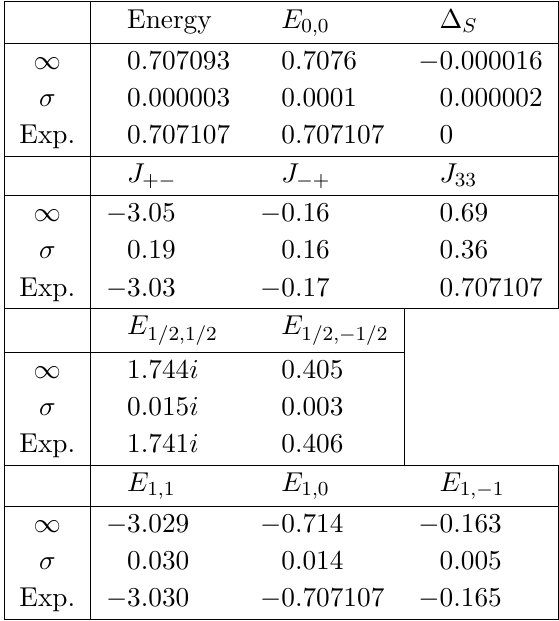
Table 13 . Extrapolations of gauge invariants of an SL(2, C ) solution describing 0-brane with θ = π and ρ ≈ 2 . 07 in the k = 2 model with J = 1 boundary conditions. Expected values of invariants 2 that depend on ρ are not exact because they are based on its estimated value ρ = 2 . 07